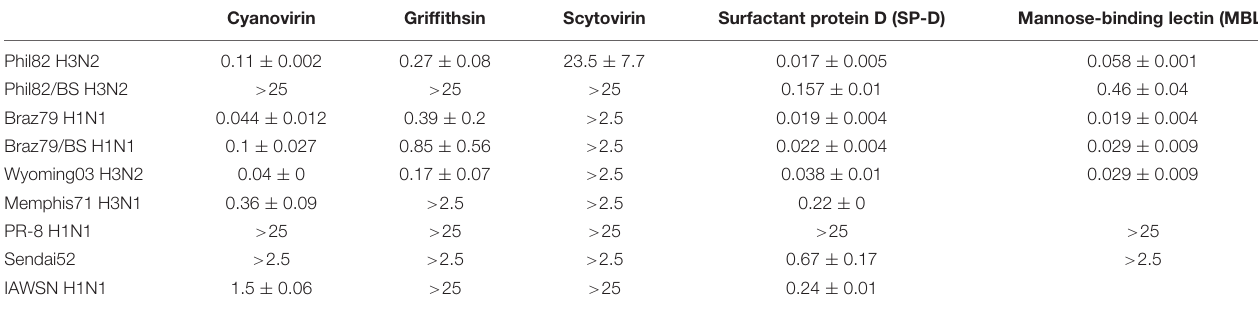
TABLE 2 | Hemagglutinin (HA) inhibition of IAV strains by bacterial and human lectins. Cyanovirin Griffithsin Scytovirin Surfactant protein D (SP-D) Mannose-binding lectin (MBL)